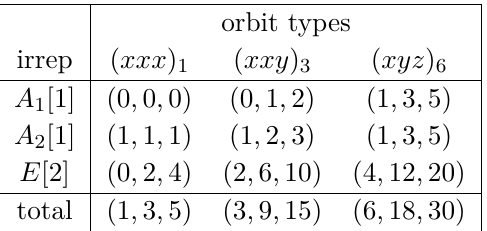
Table 13. As for table 10 but for frames with d ref = ( n, n, n ) . See table 7 for orbit-type composi- tions.